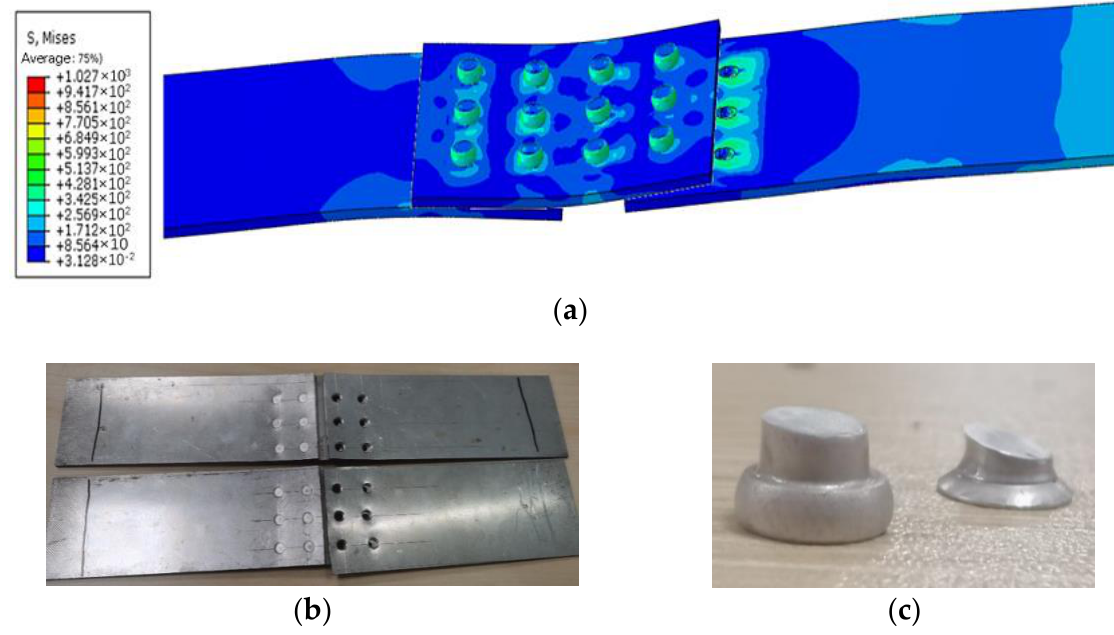
Figure 18. Comparison of failure modes of the simulation and experiment: ( a ) simulation results; ( b ) experimental results; ( c ) rivet shear failure results.